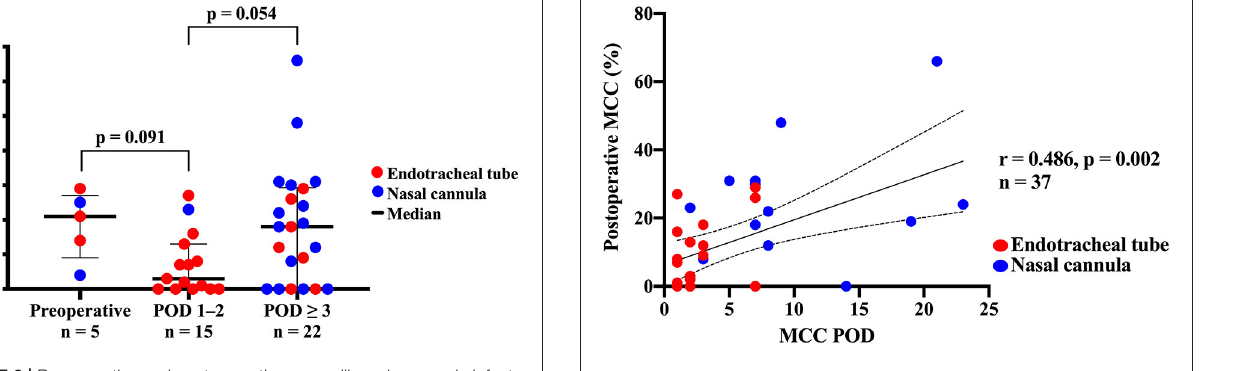
FIGURE 4 | Correlation of post-operative mucociliary clearance function with post-operative day of the scan. A direct correlation was observed between the post-operative day that the mucociliary clearance scan was performed and percentage of mucociliary clearance measured on that day. Red dots denote those who were intubated during their scan, and blue dots indicate those who had nasal cannula studies